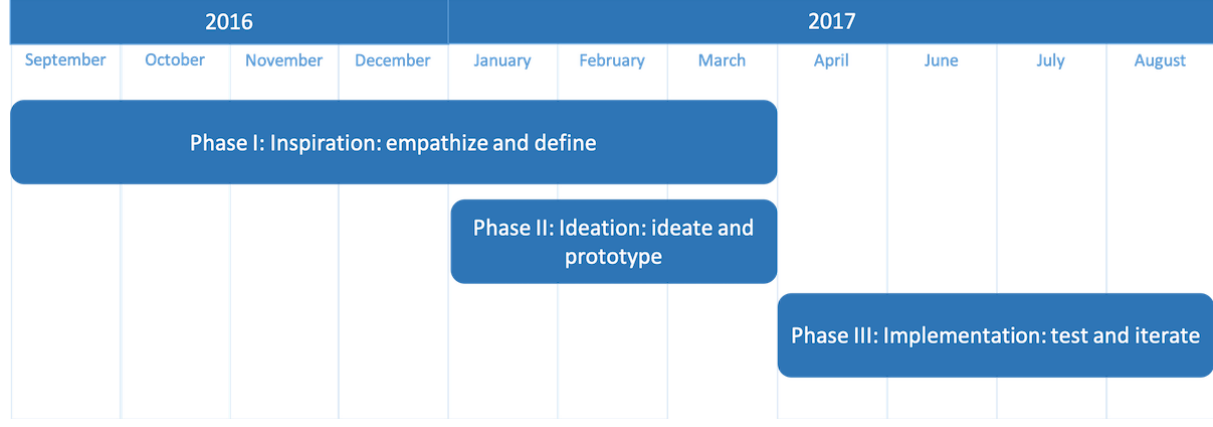
Figure 1. The human-centered design process for Open MS